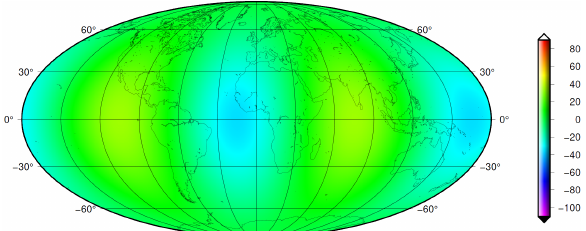
Fig. 3. Geoidal heights given in Fig. 2 minus geoidal heights given in Fig. 1 (in meters) in Mollweide projection. mean = 0.05 m, min = −34.92 m, max = 34.94 m.